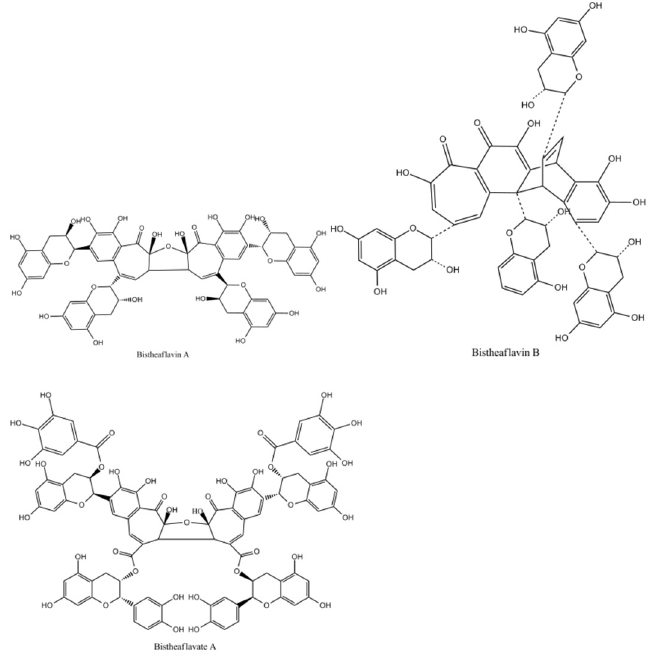
Figure 12. The Structures of bistheaflavate A, B, and theaflavate C.